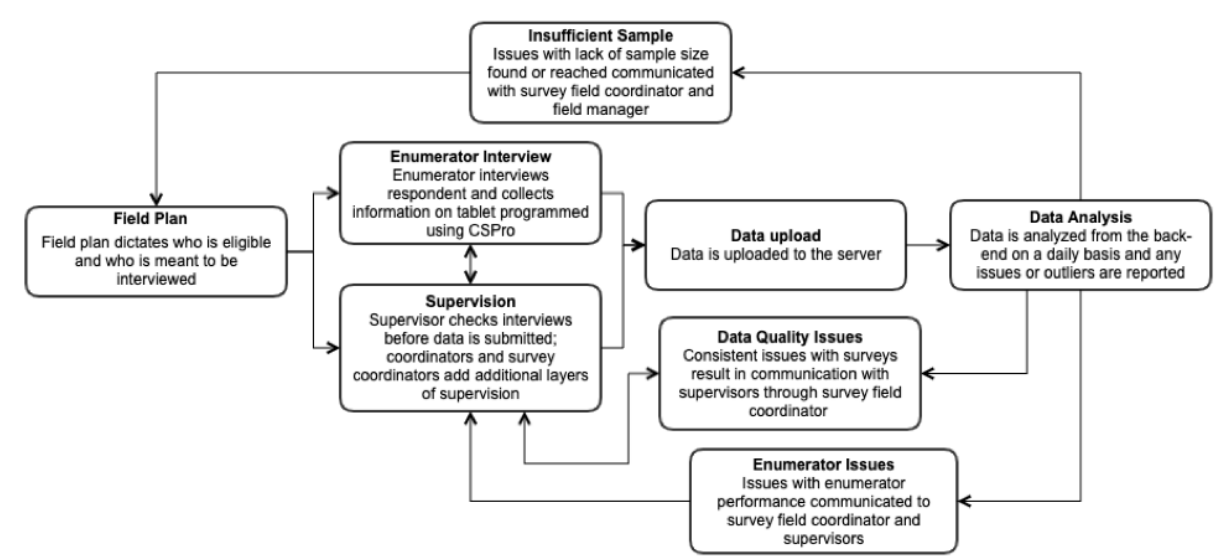
Figure 2. Data flow and feedback in Kilkari women’s